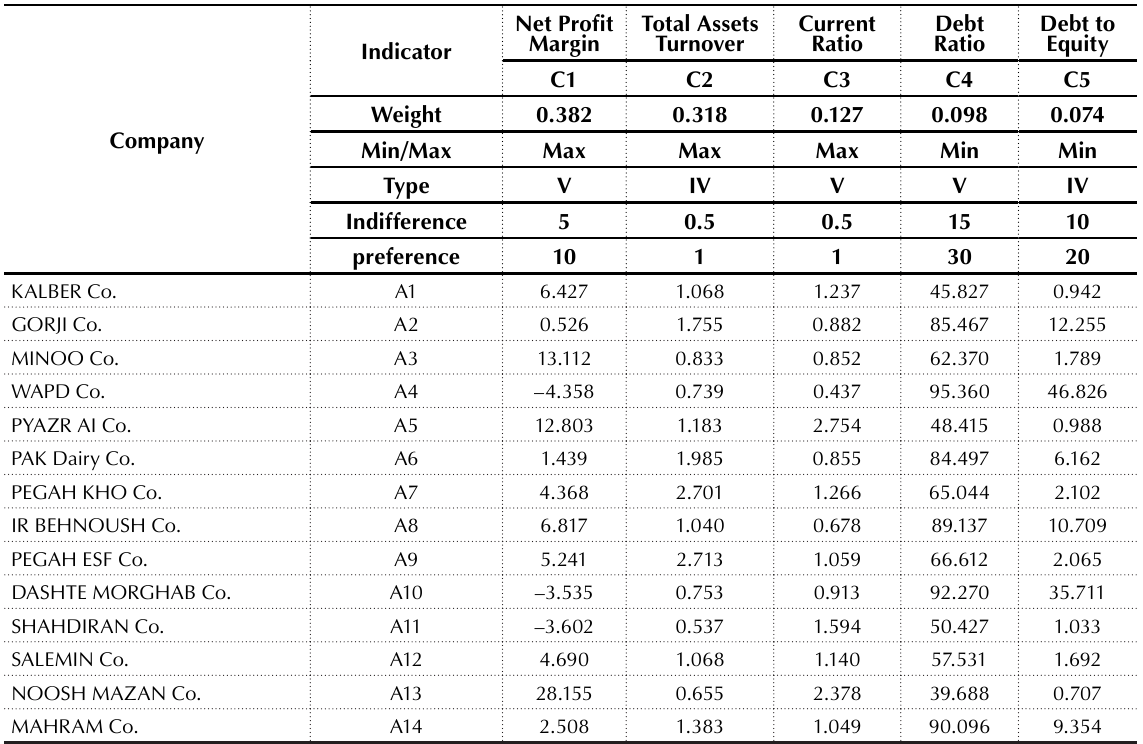
Table 3. Decision